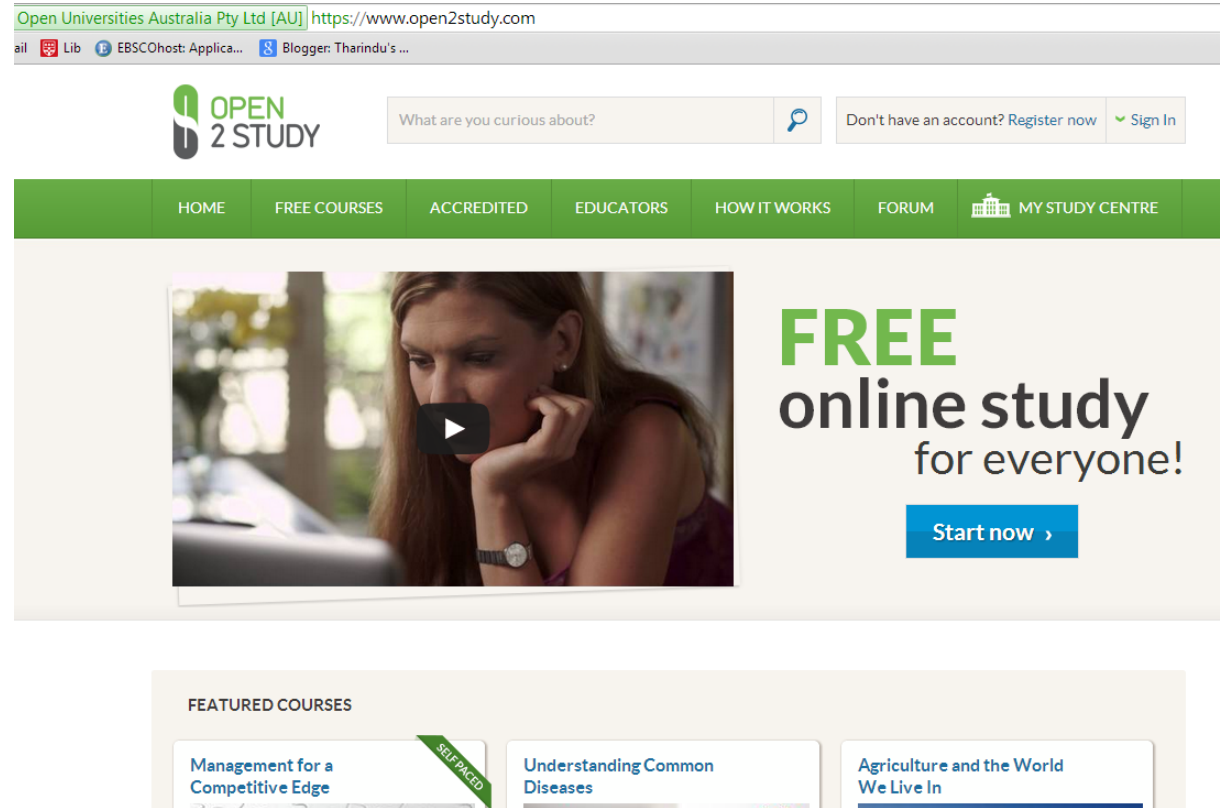
Figure 3. Open2Study platform.